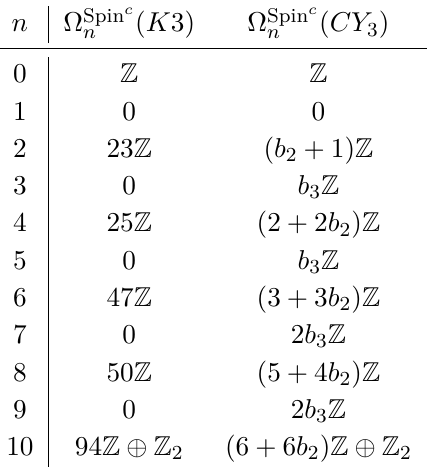
Table 25 . Spin c cobordism groups of CY manifolds, Ω Spin c